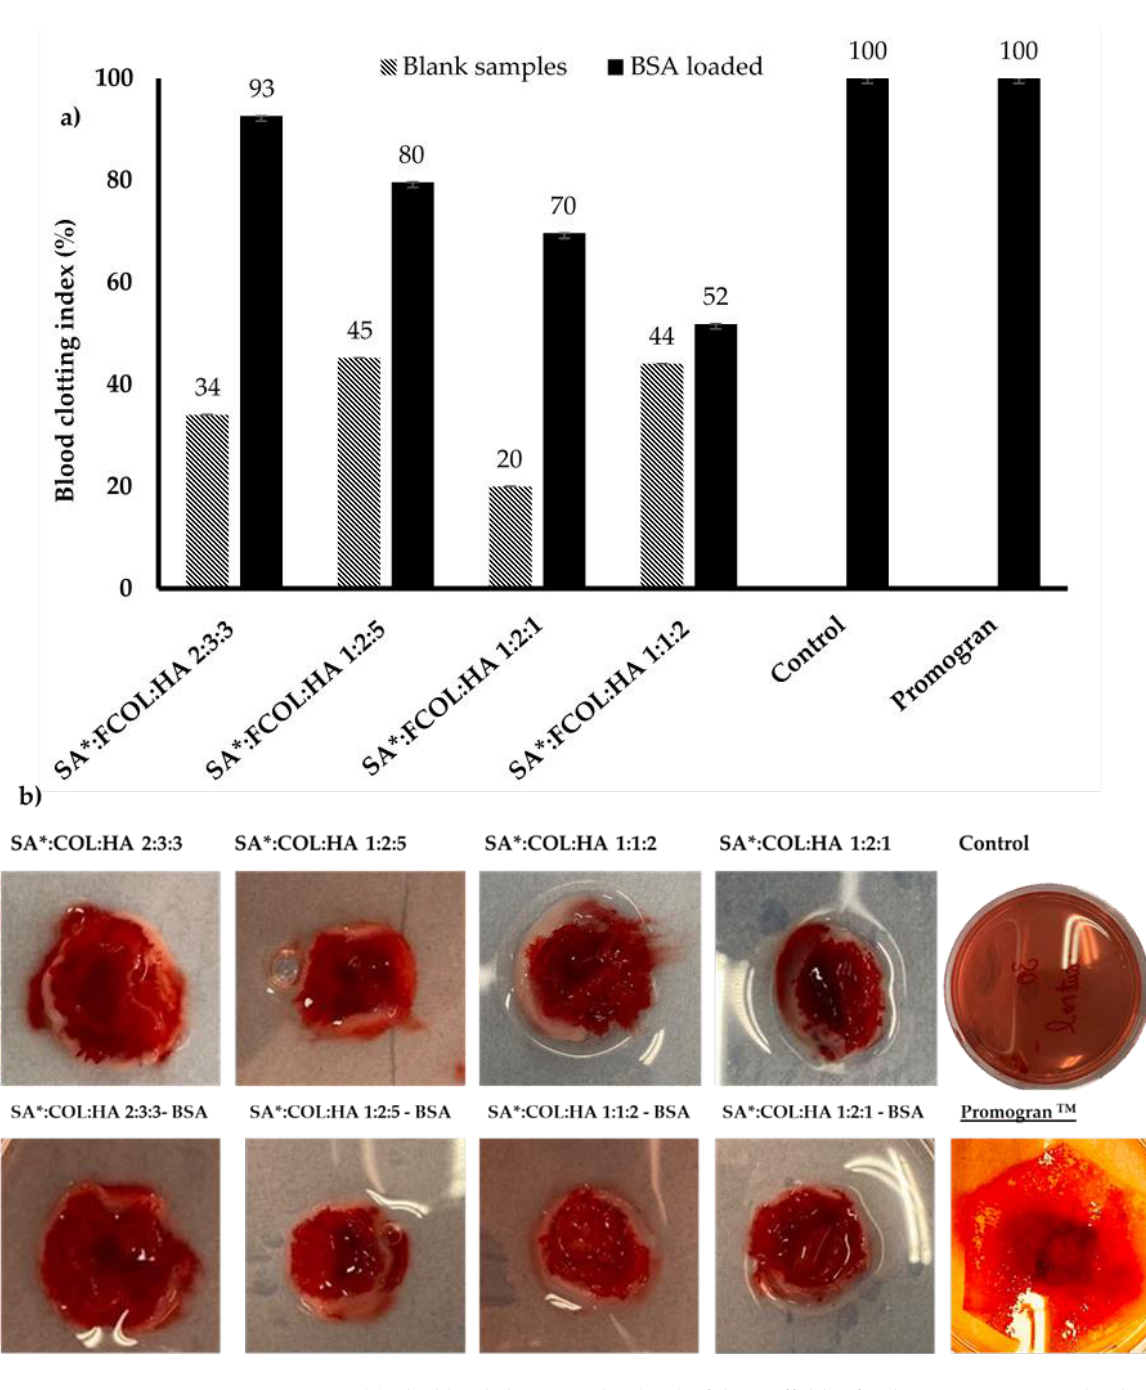
Figure 12. ( a ) The blood clotting index (BCI) of the scaffolds after being in contact with whole human blood; ( b ) photographic images of the scaffolds after incubation. blood; ( b ) photographic images of the scaffolds after